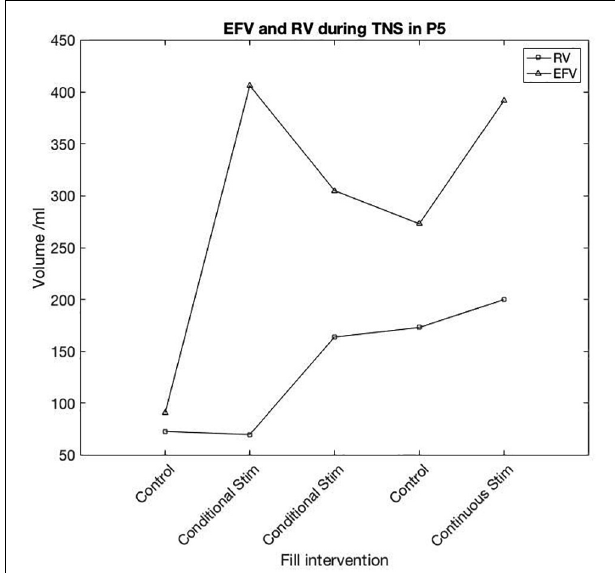
FIGURE 4 | Participant 5 TNS session results. First reflex detrusor contraction (RV) and End Fill Volume (EFV) are shown for each fill in the session. Following the first conditional TNS fill, a noticeable change in volume prior to the first detrusor contraction was seen in each subsequent fill both with and without